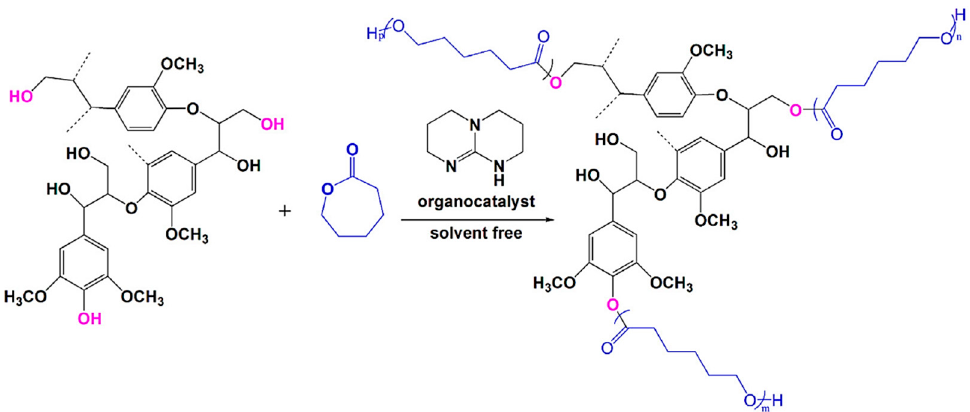
Figure 28. Solvent-free ROP to produce lignin–graft–poly ( ε -caprolactone) copolymers. Reproduced with permission [94].